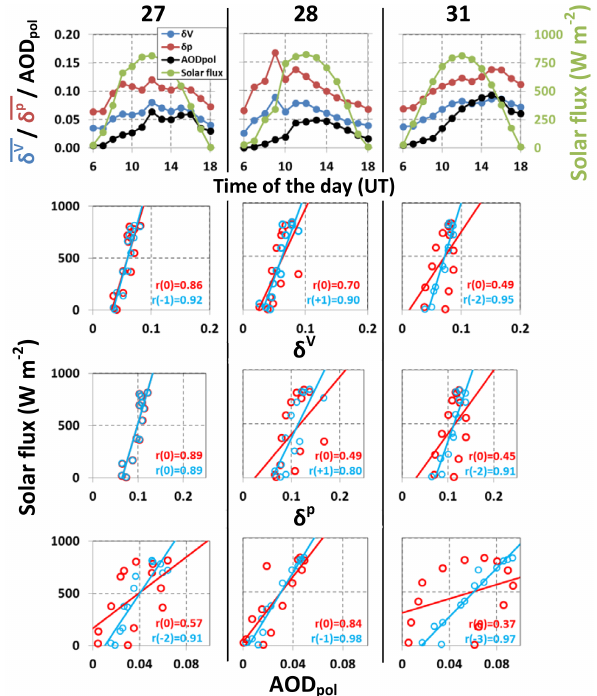
Figure 8. (top) Diurnal evolution of δ V , δ p , AOD pol , and solar fluxes on 27, 28, and 31 March between 06:00 and 18:00UT; (cen- ter/top) scatter plot of the solar flux vs. δ V ; (center/bottom) scatter plot of the solar flux vs. δ p ; (bottom) scatter plot of the solar flux vs. AOD pol . In each scatter plot, straight lines are linear regression lines; the red color corresponds to t = 0; the blue color corresponds to t = t opt . The values of r(t) are reported in each scatter